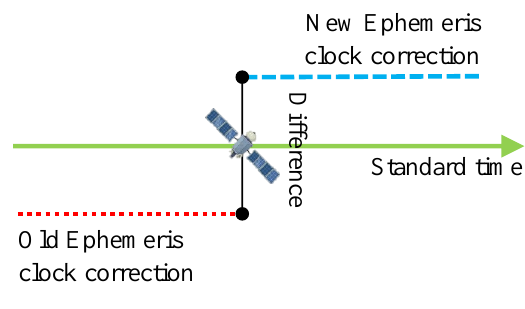
Figure 7. Schematic diagram of